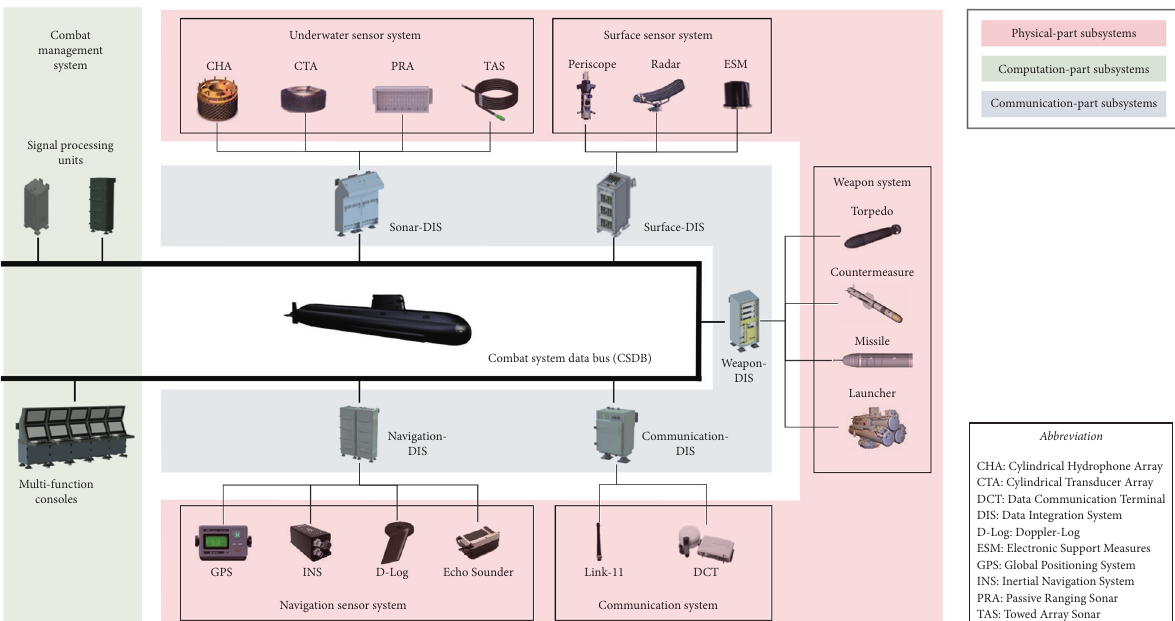
Figure 1: Simplified configuration of the naval combat system classified into three components: physical, computation, and communication